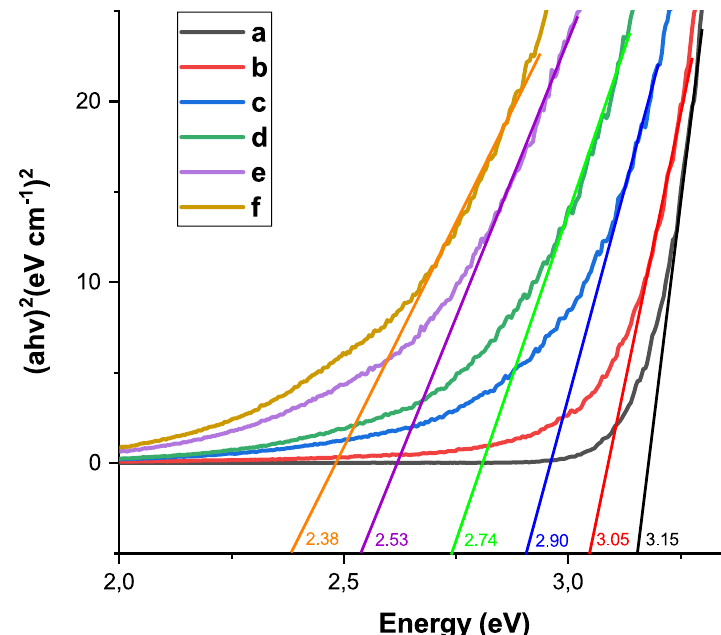
Fig. 3 The Tauc Plot of a TiO 2 , b TiO 2 –Fe(1:0.05), c TiO 2 –Fe(1:0.1), d TiO 2 –Fe (1:0.2), e TiO 2 –Fe(1:0.5), and f